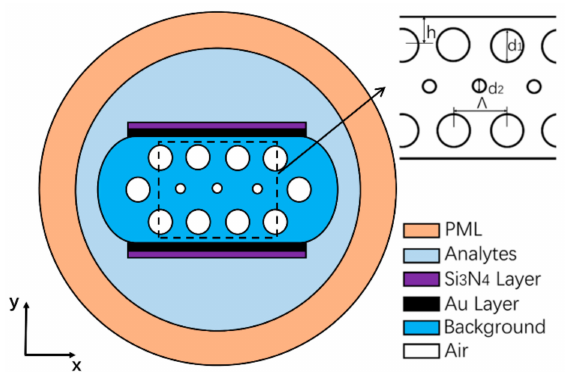
Figure 1. Schematic diagram of the proposed dual-side polished PCF